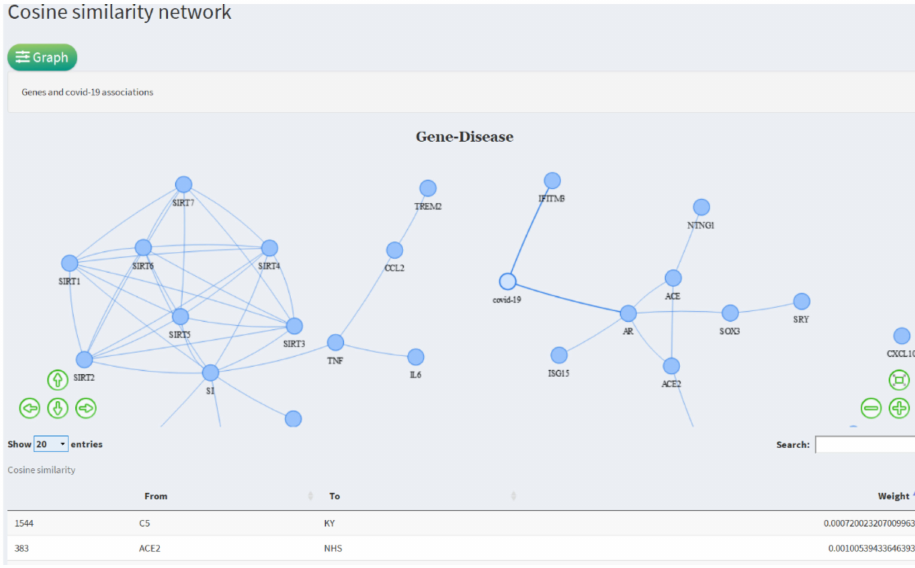
Figure 6. Disease–gene association network obtained by cosine